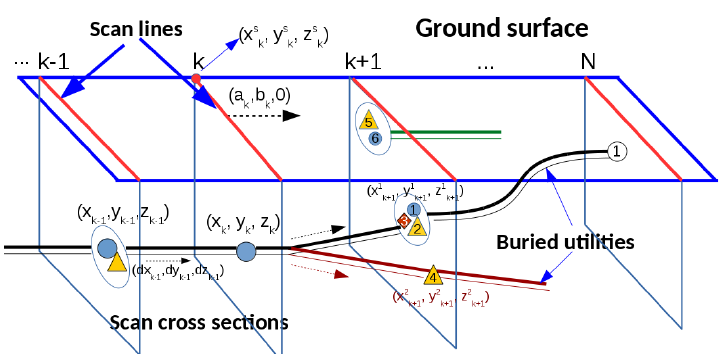
Figure 2. A schematic of the configuration of scan cross-sections. In this figure, ( a k , b k ,0 ) is the normal ) are the coordinates of the start point of the k -th scan vector of the k -th scan cross-section; ( x c , y c , z c k k k line; ( x k , y k , z k ) are the coordinates of a hypothesized detection on the k -th scan cross-section; and ( dx ) represents the longitudinal direction of the related utility at the hypothesized k , dy k , dz k